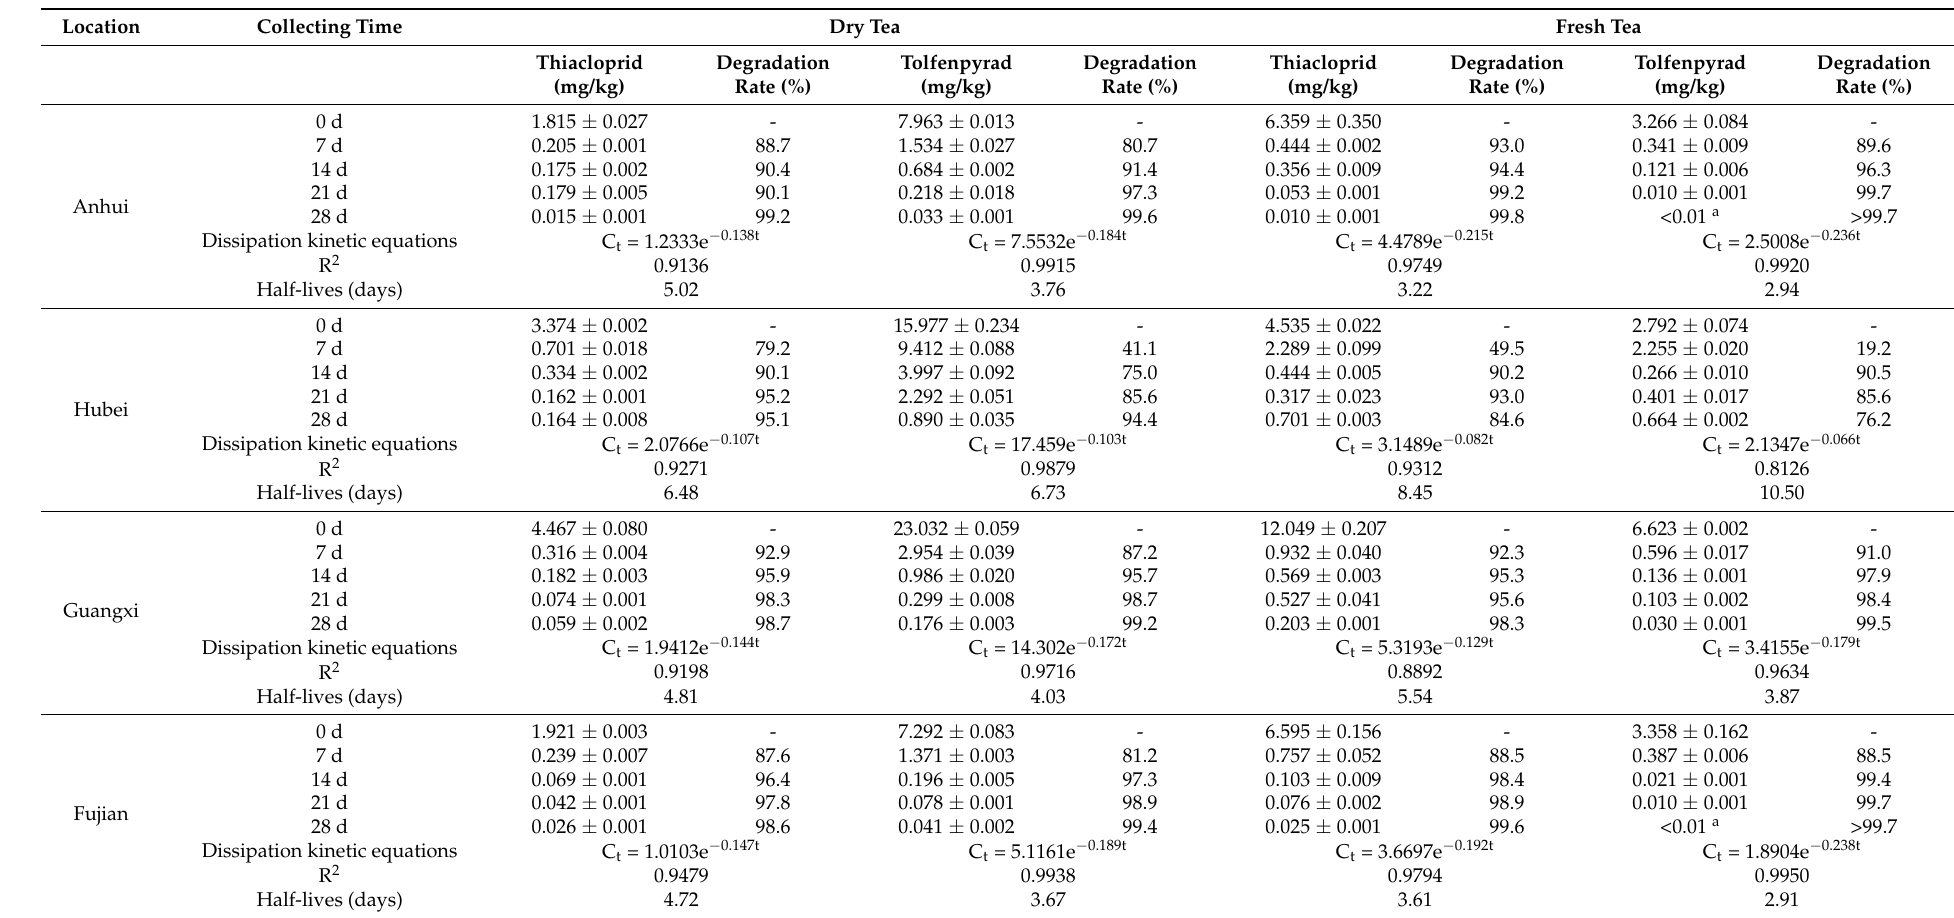
Table 3. The residue levels and relative dissipation parameters of thiacloprid and tolfenpyrad in tea were collected at different